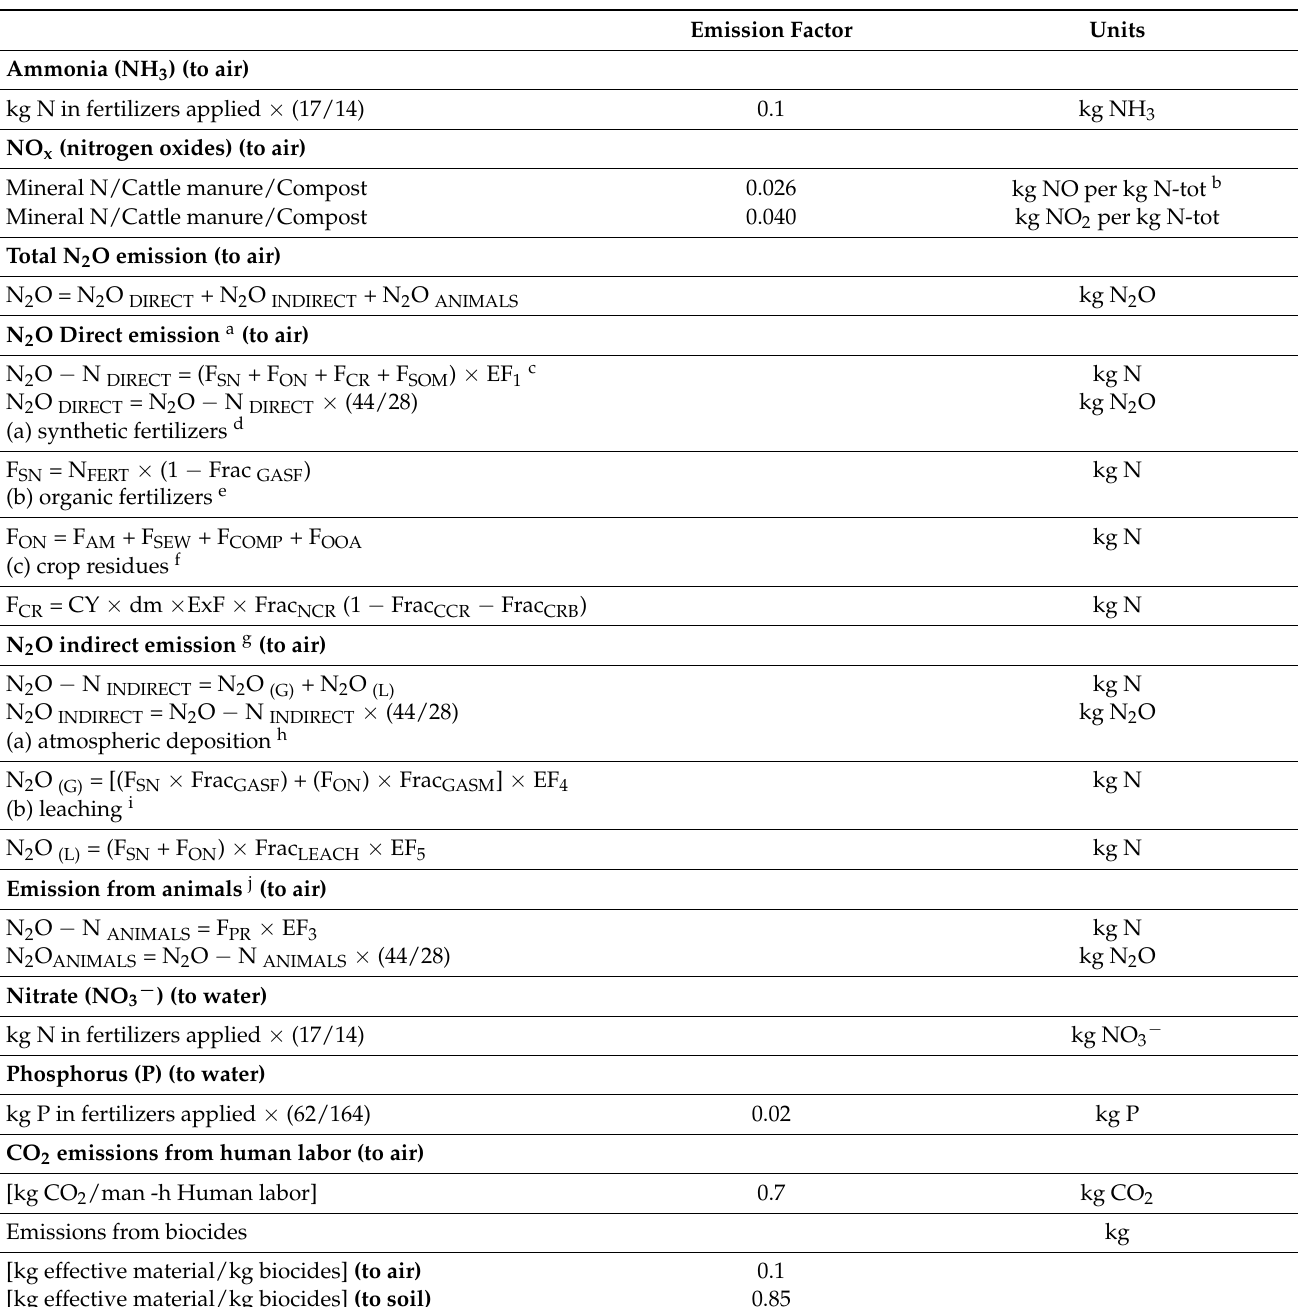
Table A1. Calculation method and emission factors for the application of inputs in the open field